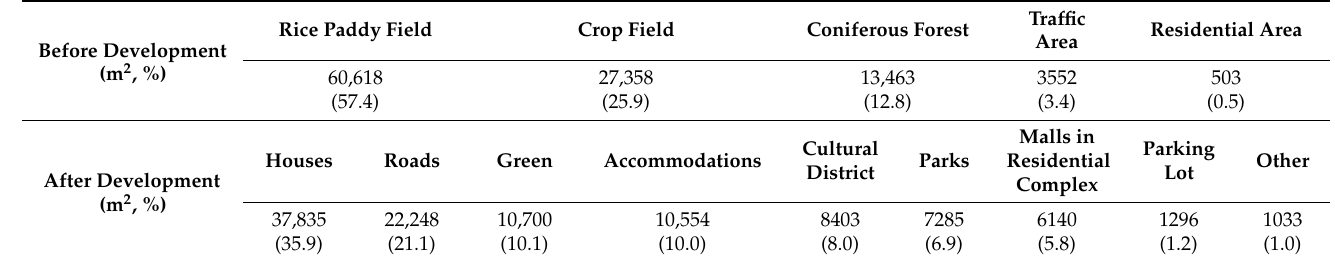
Table 1. Land use before and after the development.